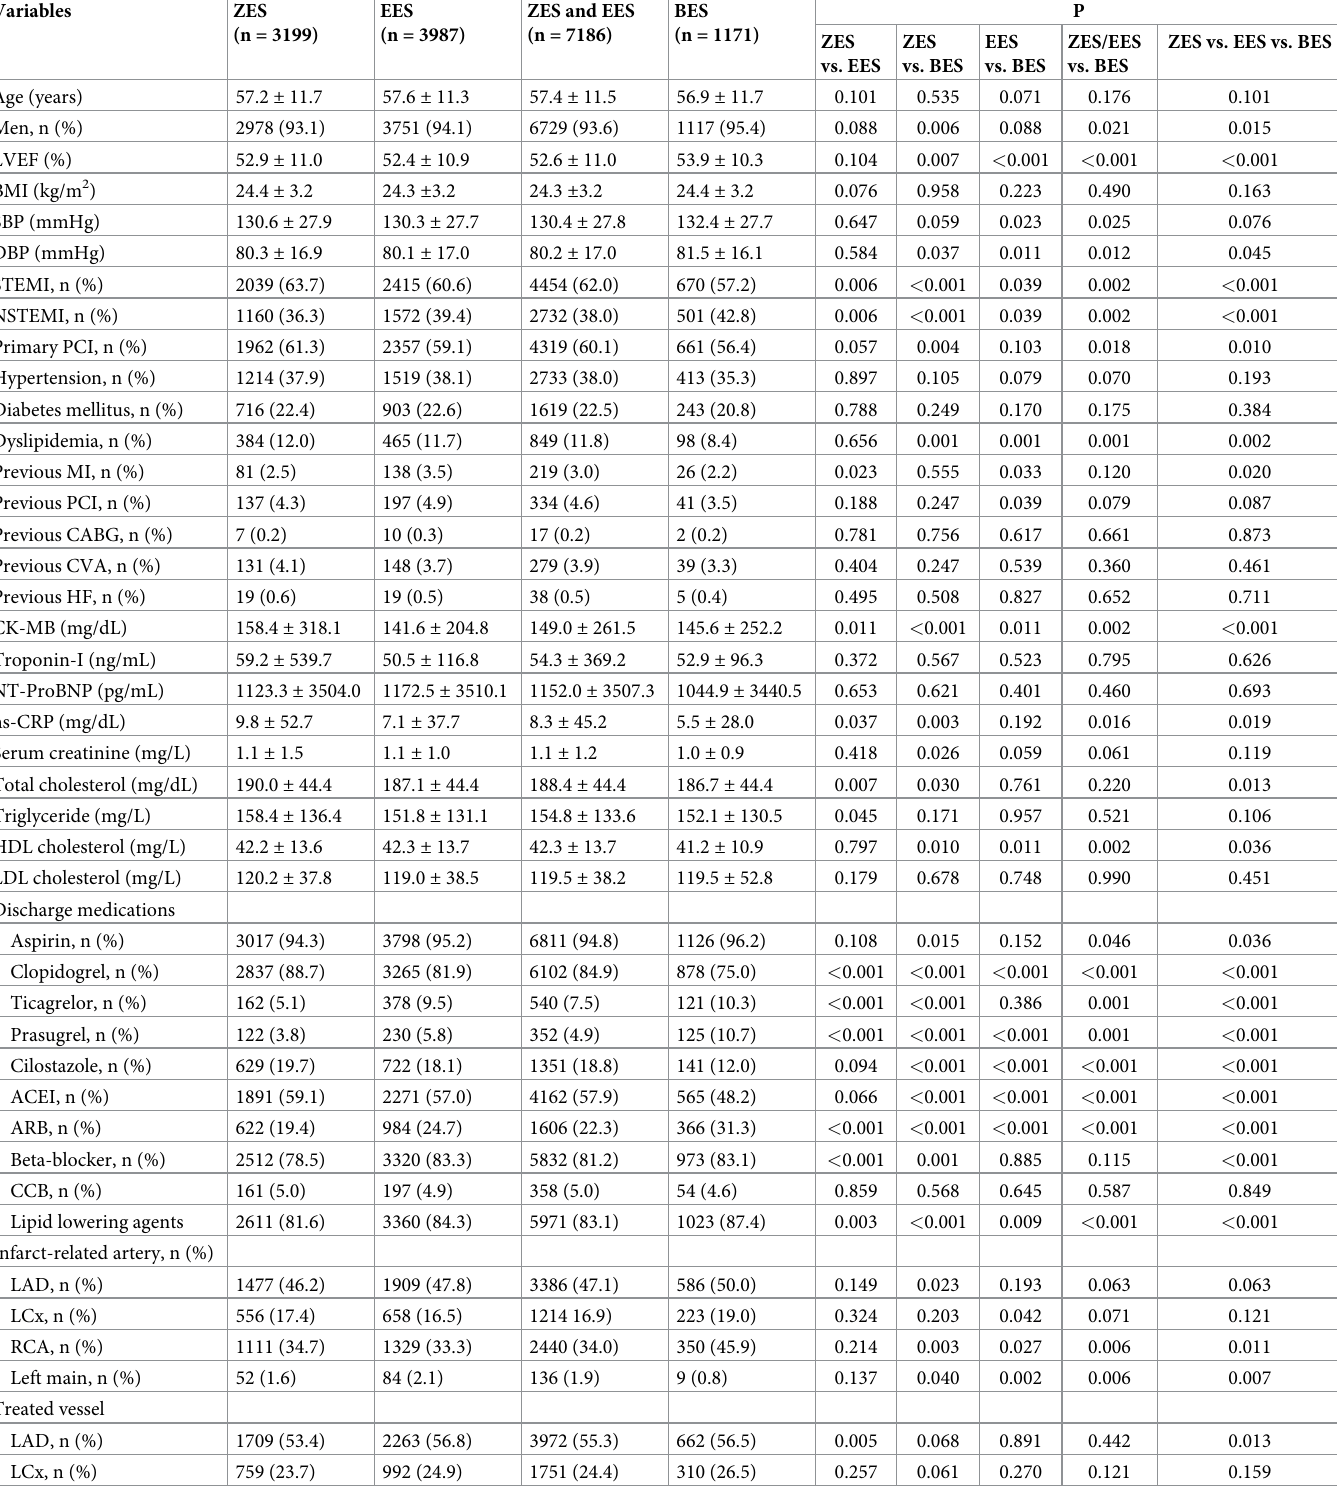
Table 1. Baseline clinical, laboratory, and procedural